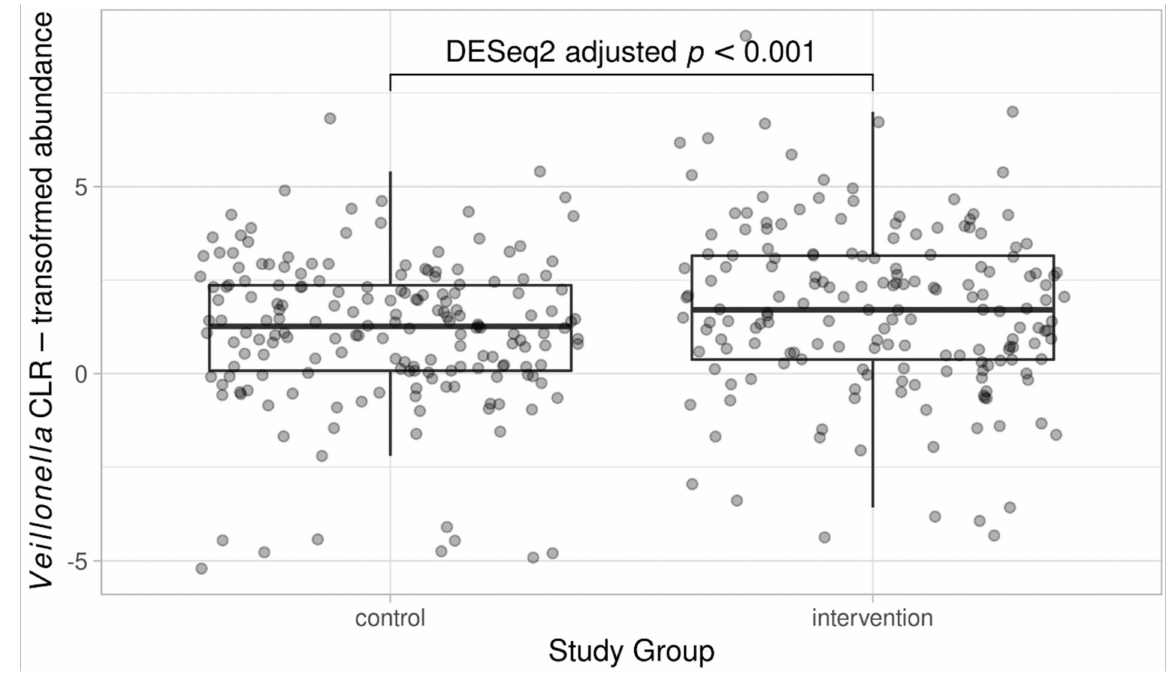
Figure 3. Abundance of genus Veillonella in the dietary counselling intervention and control groups. For illustration, CLR-transformed count data is